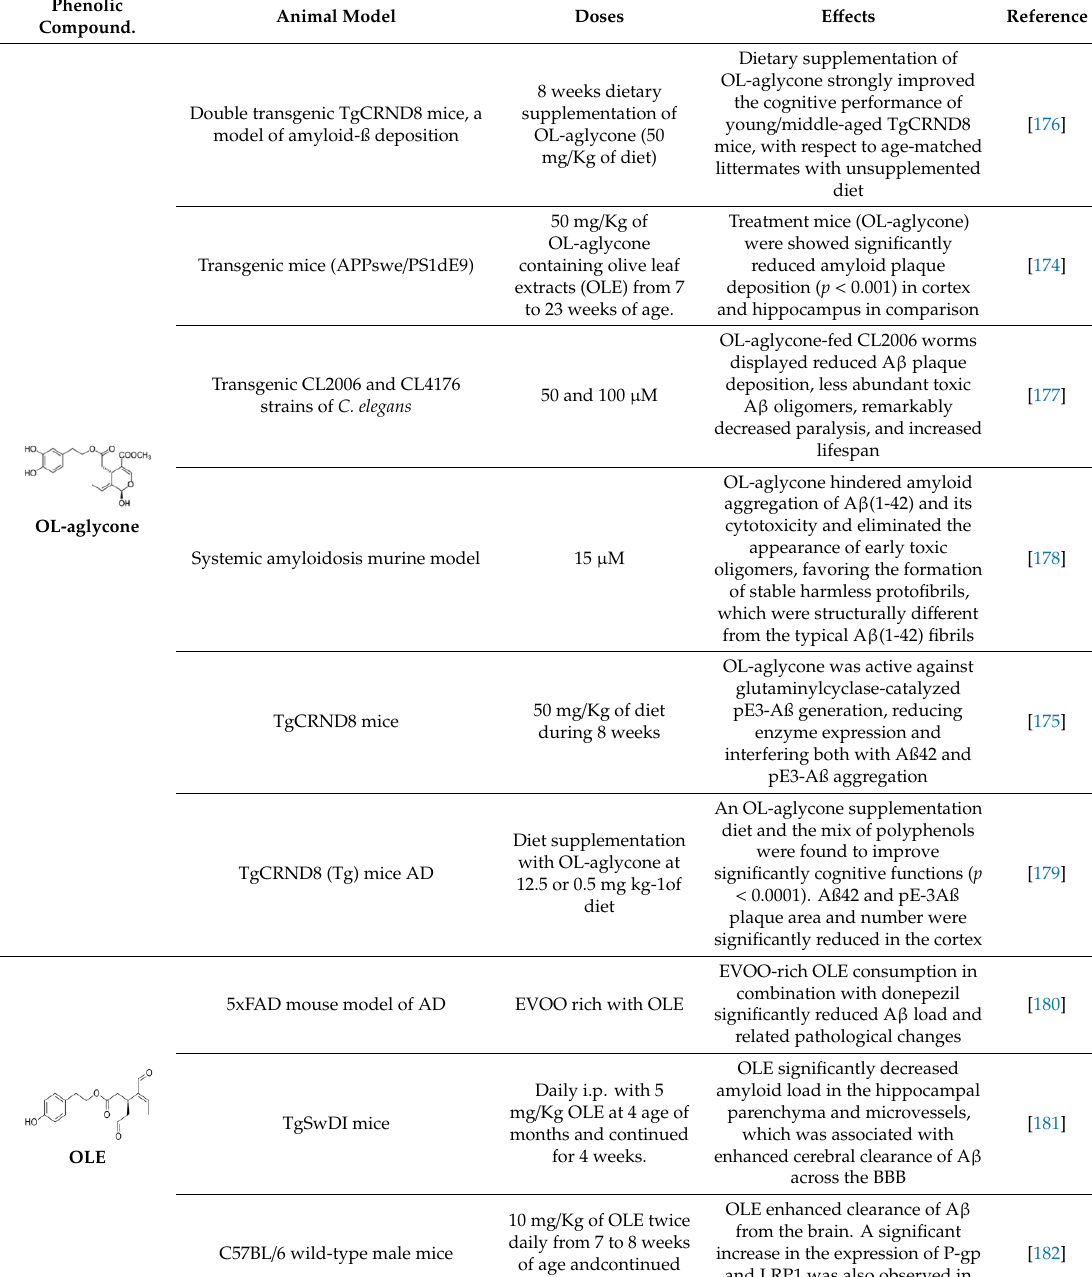
Table 6. In vivo studies that corroborate the effects of secoiridoids from the olive tree in different types of neurodegeneration processes. Phenolic Compound.